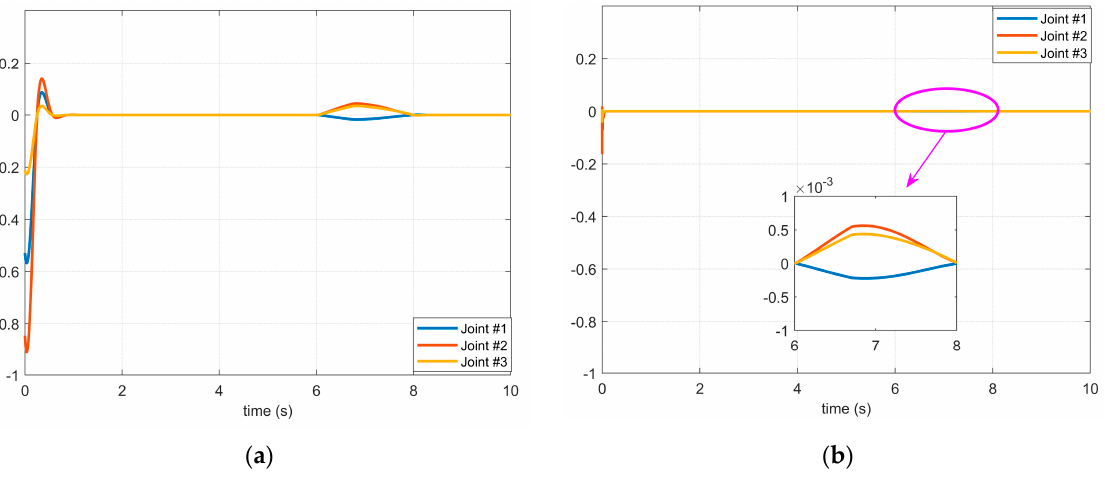
Figure 6. The effect of the 2nd disturbance on the servo motor of each axis of the manipulator: ( a ) The BKS operator is not applied. ( b ) The BKS operator is applied.